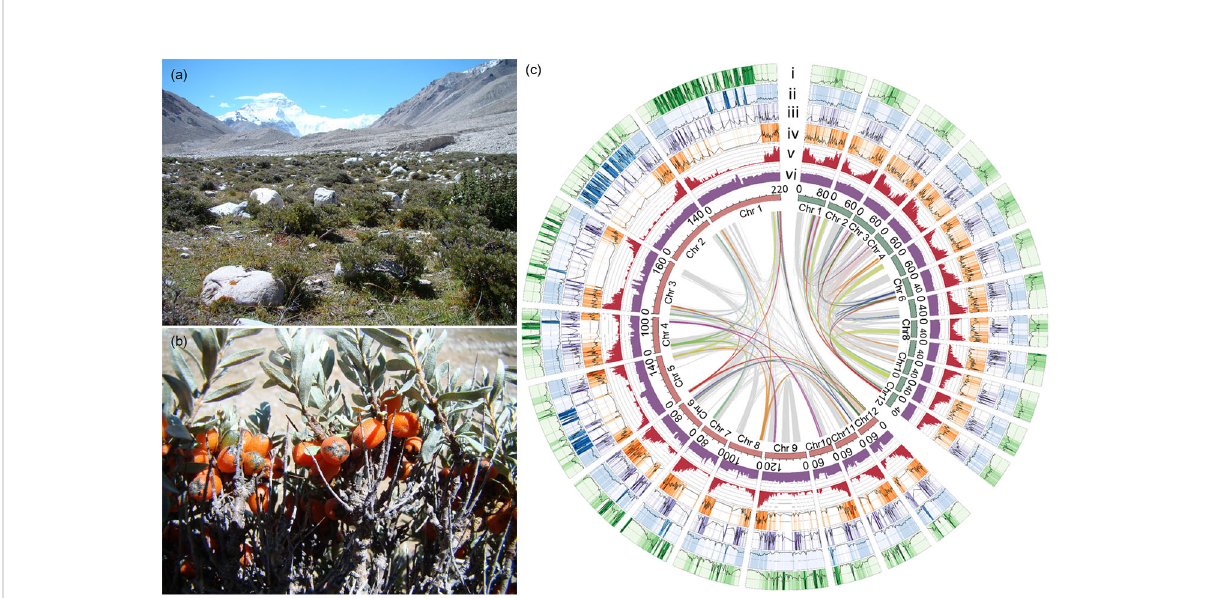
FIGURE 1 Habitat, morphological characteristics, and genomic features of ” H. tibetana. (A) High altitude habitat of ” H. tibetana ; (B) Mature ” H. tibetana fruits on the tree; (C) Circos diagram of the chromosome-level ” H. tibetana (red inner circle on the left) and ” H. rhamnoides (green inner circle on the right) genome feature. Chr: chromosome. Window size: 1 Mb with non-overlapping. From outside to inside: i, percent of total ” Gypsy (0- 100%); ii, percent of total ” Copia (0-100%); iii, intact ” Gypsy number (0-8); iv, intact ” Copia number (0-20); v, gene count (0-100); vi, GC content (0-100%). The gray line in the circle is the collinearity area between species, and the color line represents the fragments of 4 copies within